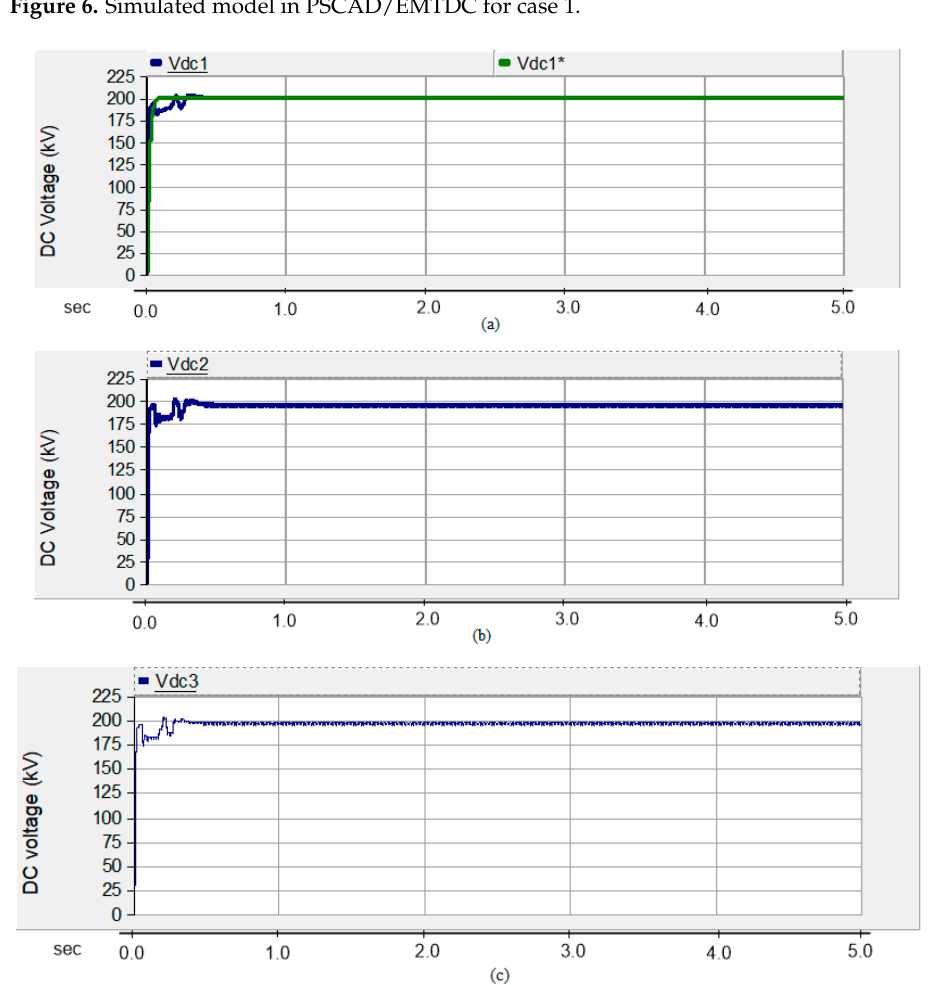
Figure 7. DC voltage at ( a ) VSC1, ( b ) VSC2, and ( c ) VSC3 terminals, respectively.